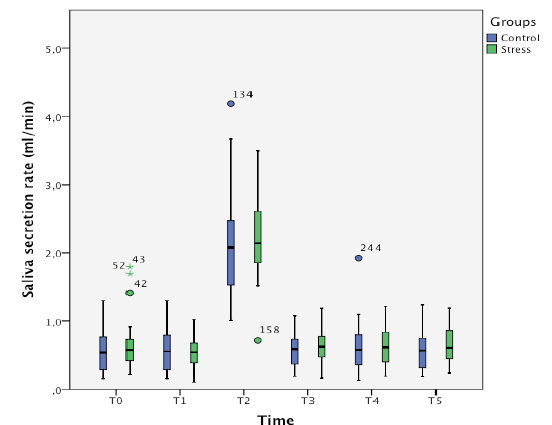
Figure 4. Saliva secretion rate during saliva collection (from T0 to T5).